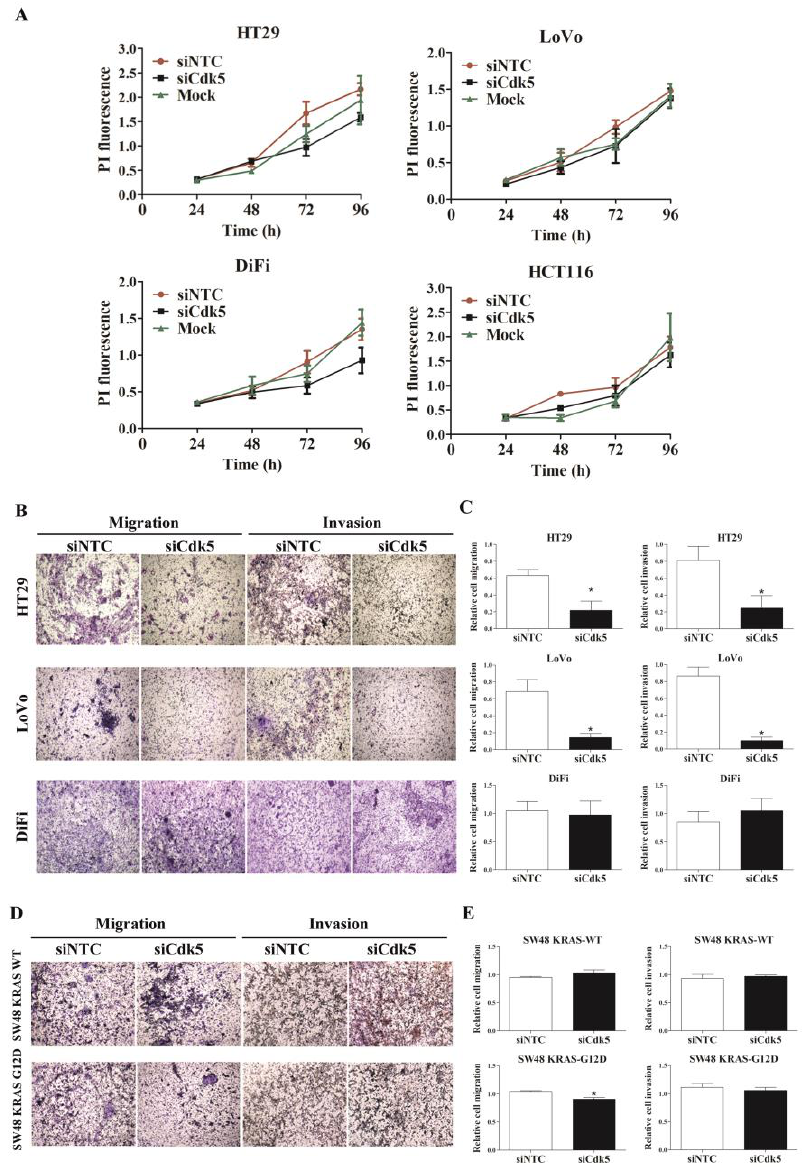
Figure 2. Effect of Cyclin dependent kinase 5 (Cdk5) siRNA-mediated gene silencing on colorectal cancer (CRC) cells proliferation, migration and invasion. ( A ) Graphic representation of HT29, LoVo, DiFi, and HCT116 time-dependent cell proliferation after Cdk5 gene silencing measured by propidium